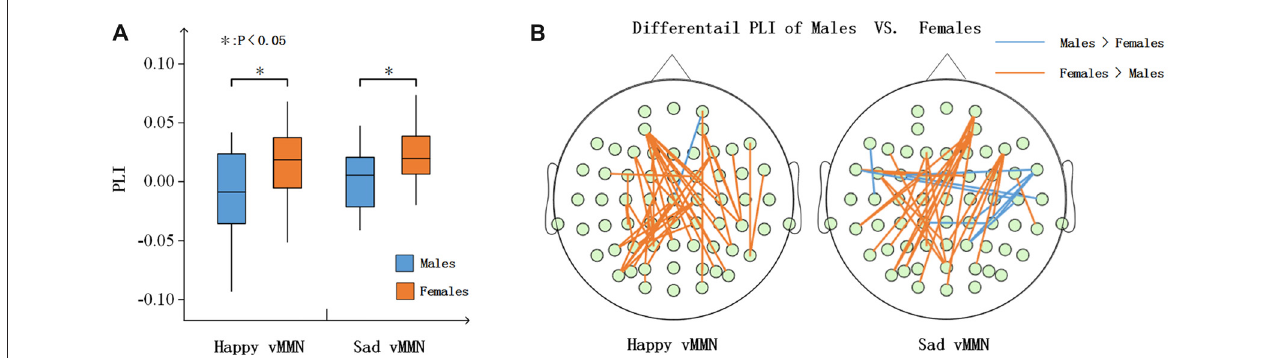
FIGURE 4 | (A) Box figure of the average PLI values for males and females in the alpha band. (B) Illustration of the difference in the PLI values between the males and the females in the alpha (150–250 ms) band. The brown lines show larger PLI values in the females than in the males, and the blue lines show larger PLI values in the males than in the females ( t -test was applied and p ≤ 0.01). ∗ p < 0.05.